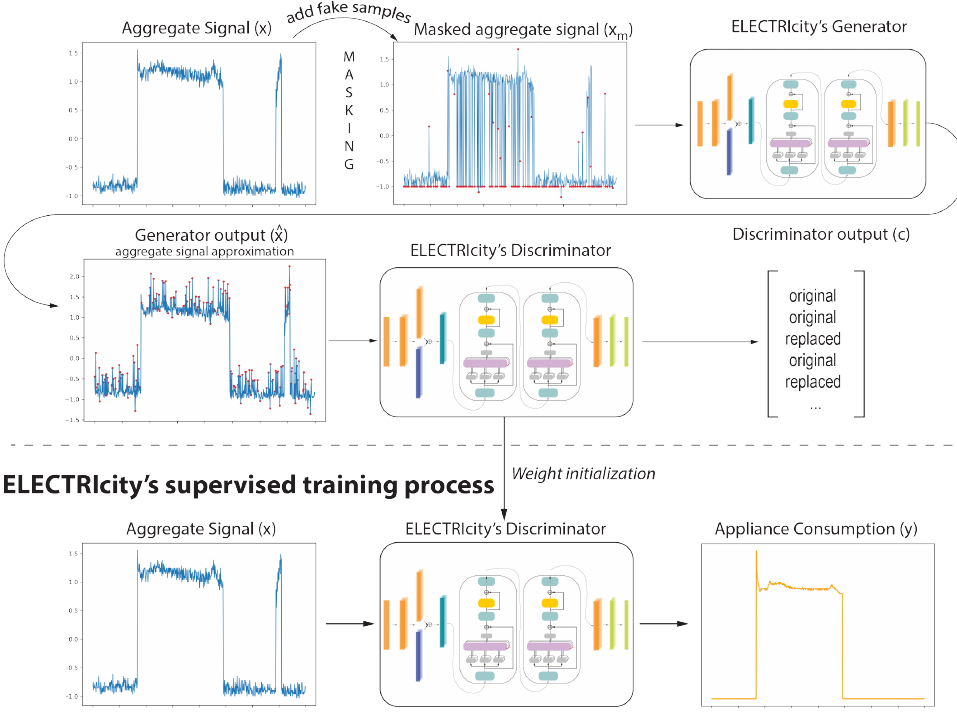
Figure 3. Overview of ELECTRIcity’s model training routine. Training is split into an unsupervised pre-training mechanism and a supervised process. During pre-training, the aggregate signal is masked at random positions with fake samples and the generator tries to reconstruct the original signal. The discriminator has to distinguish which positions of the generator output were fake (replaced) and which correspond to the original signal. During training, the generator is discarded and the discriminator is fine-tuned to predict the individual appliance consumption from the aggregate